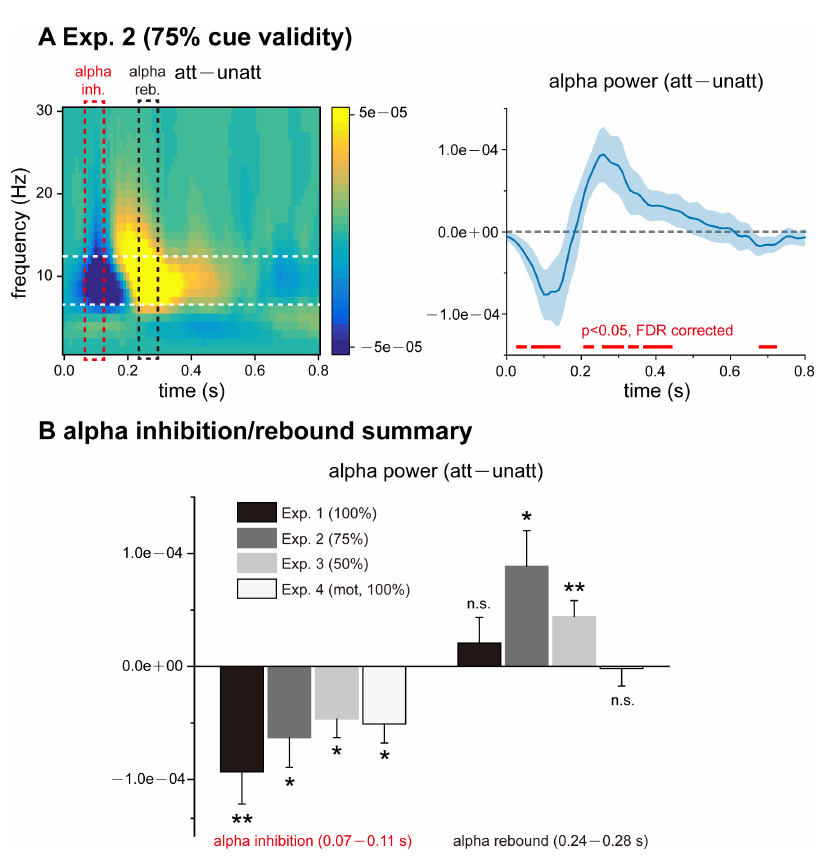
Fig 3. Results for Experiment 2 (75% cue validity) and summaryof alpha inhibition and alpha rebound. (A) Temporal responsefunction (TRF) results for Experiment 2 (75% cue validity). Left: grand average( N = 20) time–frequency plots for att–unatt TRF power difference.Right: grand average(blue lines, N = 20, mean ± SEM) time course for att–unatt TRF power within the alpha band (8–12 Hz). Red horizontal lines at the bottom indicate points showinga significantpower difference in the alpha band betweenatt and unatt ( p < 0.05, two-tailed, false discovery rate [FDR] corrected). Note the emergence of alpha-band rebound right after the alpha-bandinhibition,suggestingattentionalswitching. (B) Grand averageatt–unatt TRF alpha- band power averagedover an early (alphainhibition,0.07–0.11s, red dotted box in Fig 3A) and a subsequent late (alpharebound,0.24–0.28 s, black dotted box in Fig 3A) time range for each experiment. Experiment 1: N = 18; Experiment 2: N = 20; Experiment 3: N = 16; Experiment 4: N = 11. * p < 0.05, ** p < 0.01, t test. MOT: multiple object tracking. The data are provided in the SupportingInformation (see S2 Data).